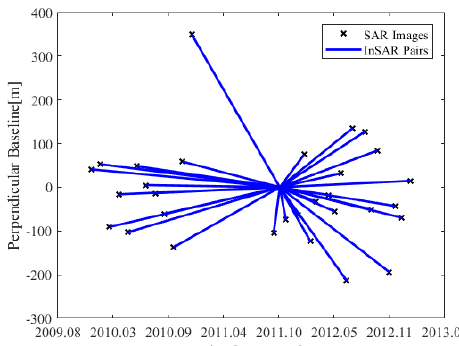
Figure 1. Baseline configuration of the TerraSAR-X dataset used in this